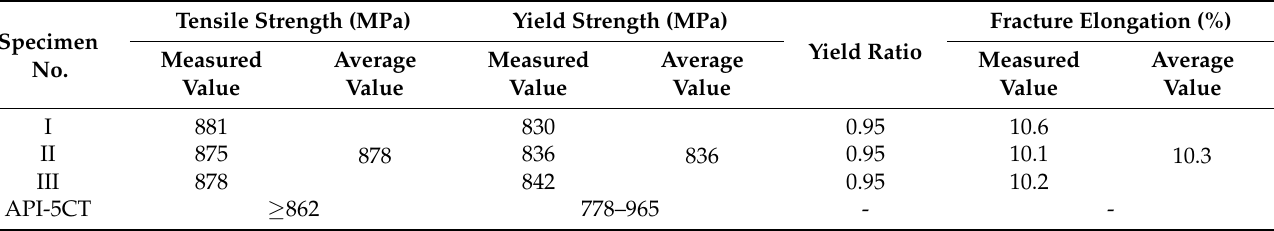
Table 2. Testing results of tubing body tensile properties.